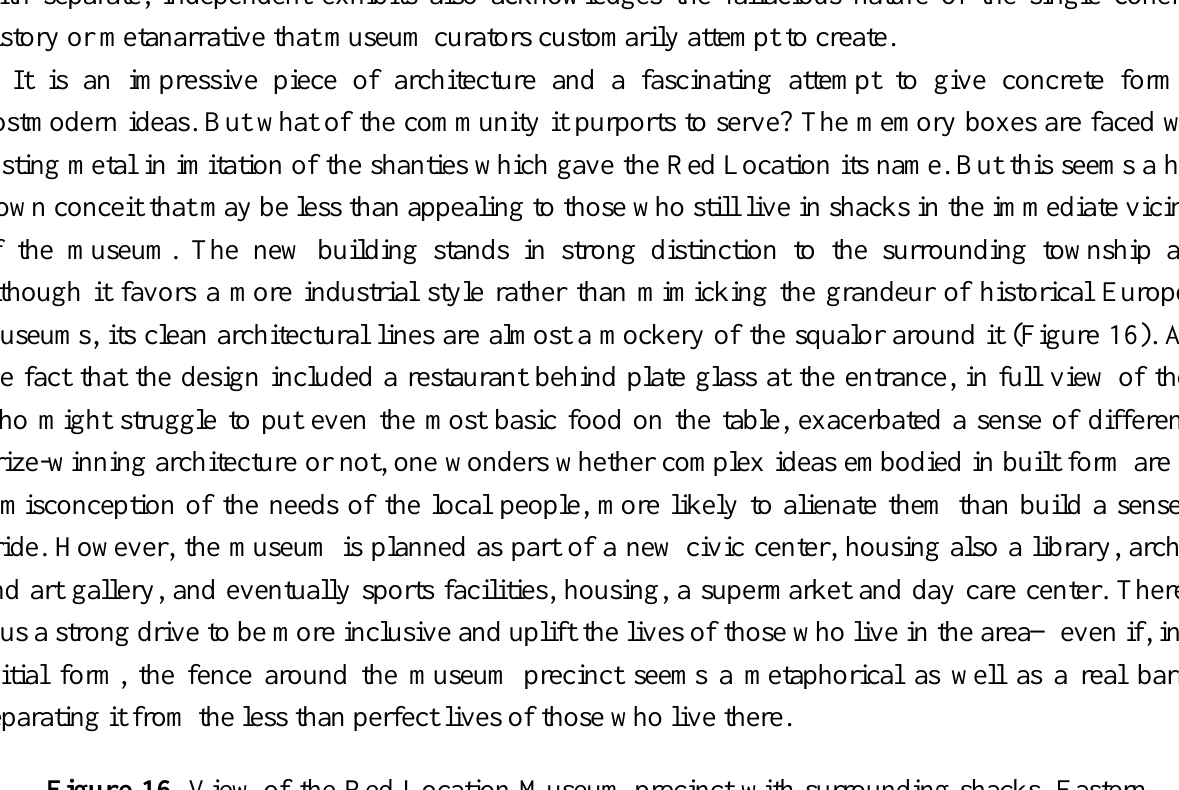
Figure 16. View of the Red Location Museum precinct with surrounding shacks, Eastern Cape (author’s